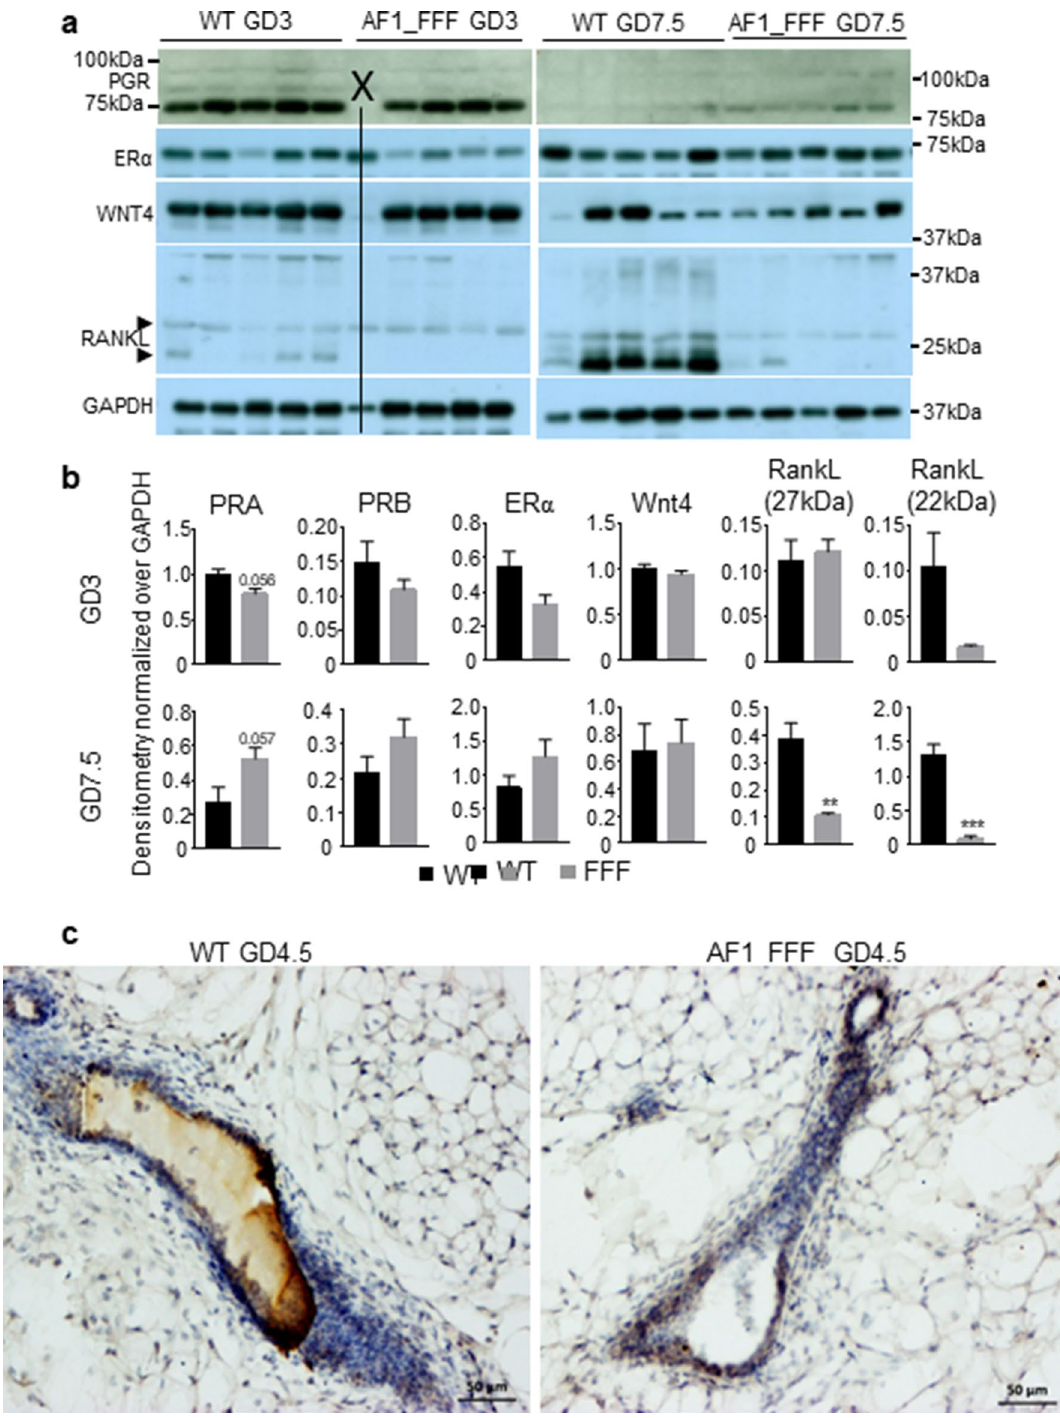
Figure 5. RANKL protein was significantly reduced in AF1_FFF mammary tissues in early pregnancy. ( a ) Protein levels of PR, ERα, WNT4 and RANKL in the mammary tissue were analysed by Western blotting analysis. Lanes indicated by X followed by a line is a defective sample. There is a upshift of PR protein bands on GD7.5 as compared to that on GD3. The major RANKL protein bands were detected are ~ 27 kDa and 22 kDa (indicated by black arrow heads) which correspond to soluble RANKL proteins. The level of GAPDH was used as a loading control. ( b ) Quantification of protein levels by densitometry. The results are expressed as mean ± SEM. **p < 0.01; ***p < 0.001. ( c ) Representative images of WT and AF1_FFF mammary sections probed with RANKL antibody and detected using VECTASTAIN Elite ABC HRP